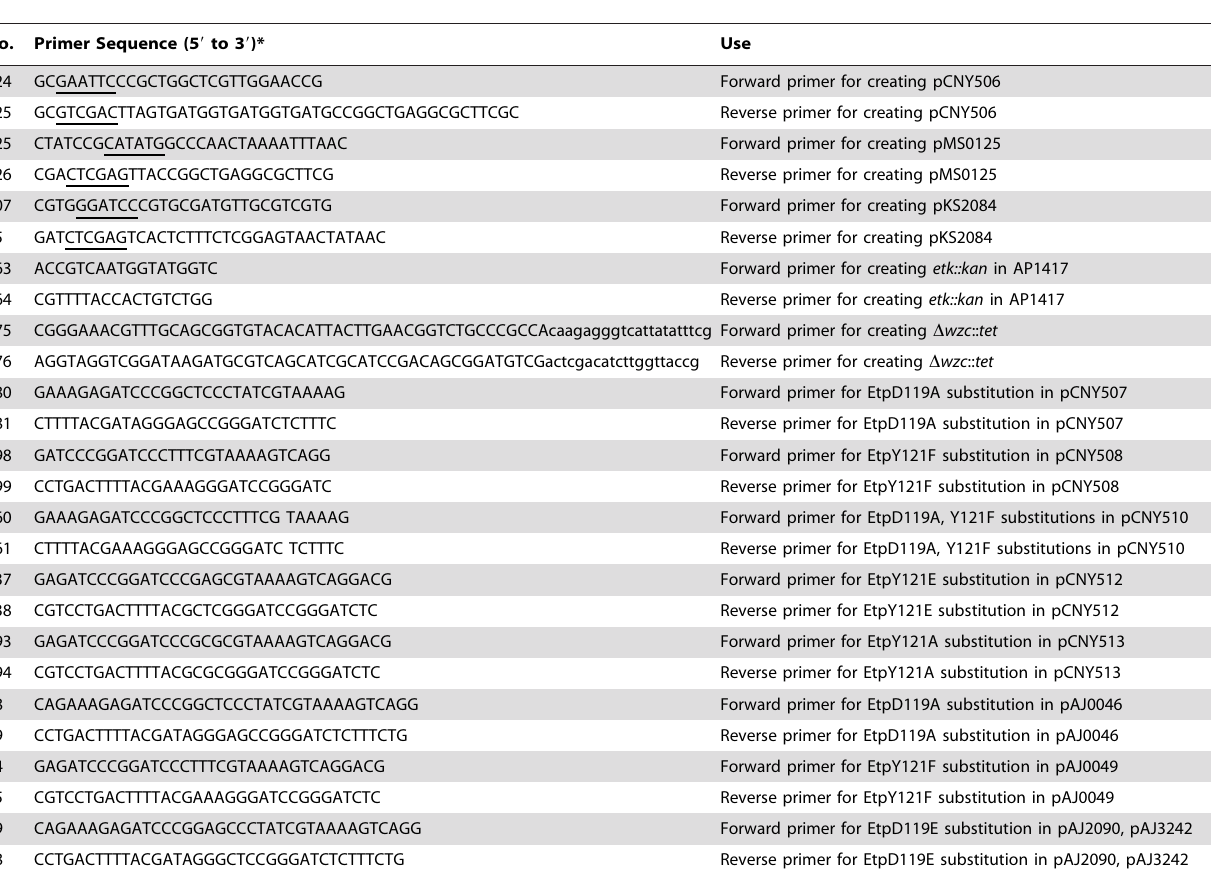
Table 4. Oligonucleotide primers used in this